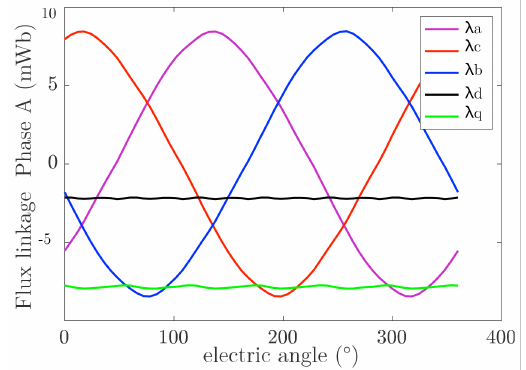
Figure 10. No load flux linkage vs. rotor